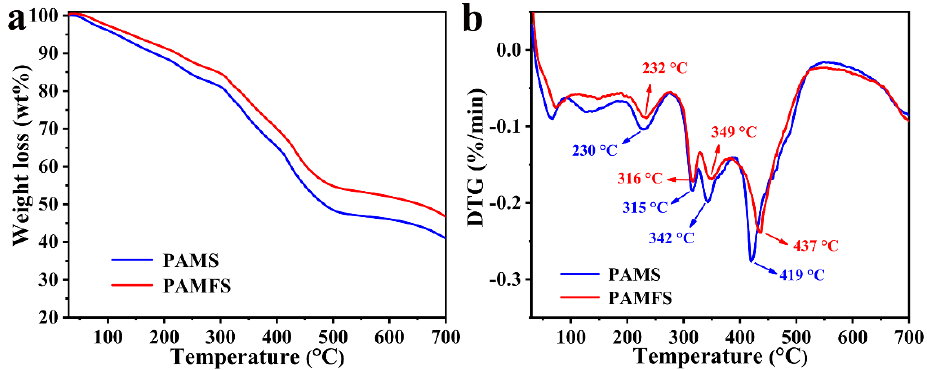
Figure 1. FTIR spectra of OSSC (a), FA (b), PAMS (c), PAMFS (d), and the physical mixture of PAMS with FA (m PAMS /m FA =10/1.5) (e).